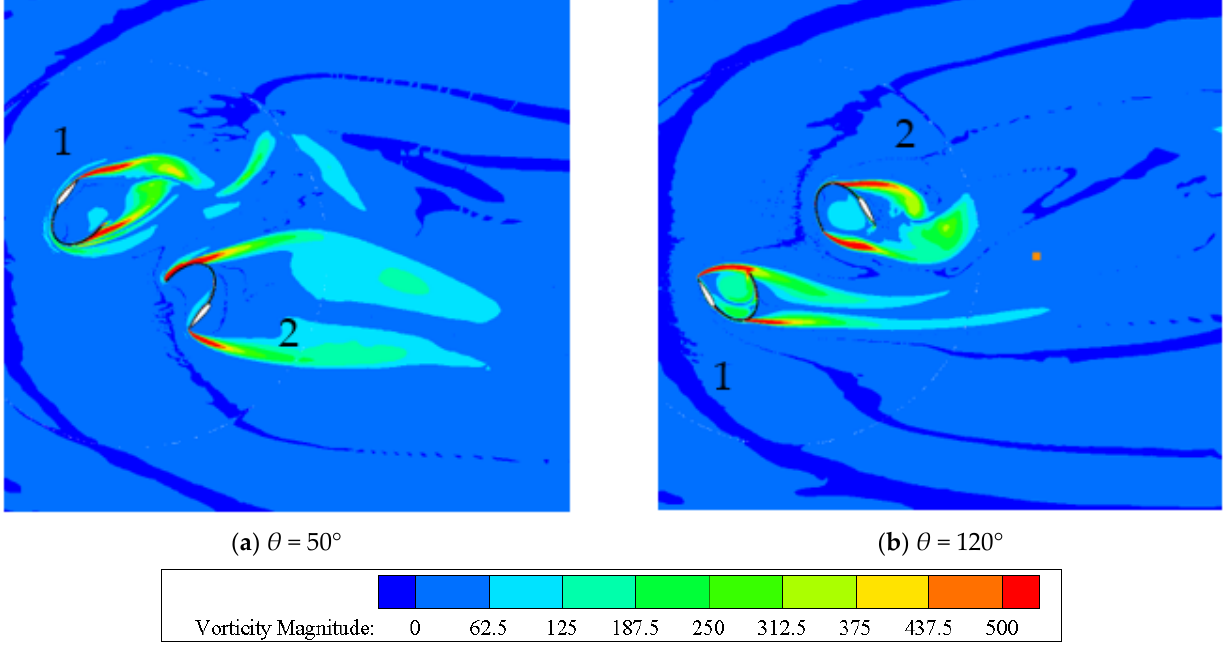
Figure 12. Vorticity magnitude of 2-bladed LDCS ( U = 6 m/s): ( a ) θ = 50°; ( b ) θ = 120°.